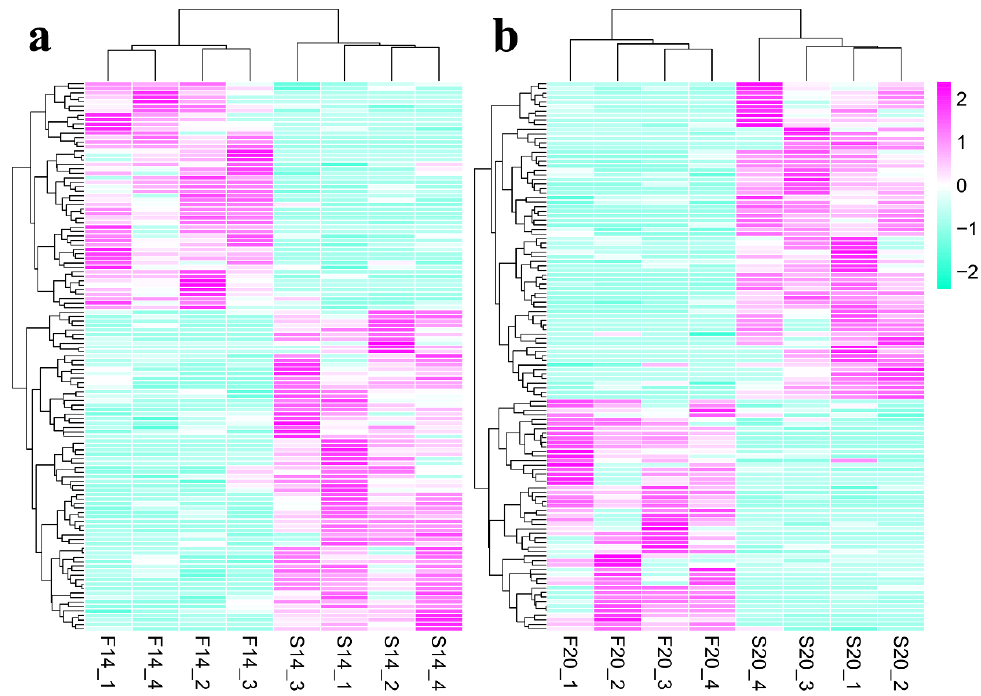
Figure 2. Clustering analysis of differentially expressed circRNAs (DECs). ( a ) Heatmap for DECs of S14 vs. F14 group. ( b ) Heatmap for DECs of S20 vs. F20 group.